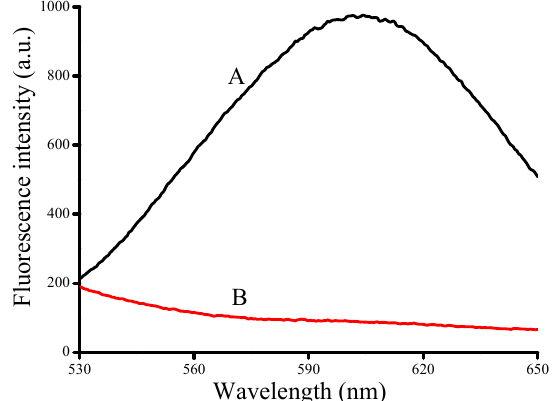
Figure 1. The feasibility of the proposed method. ( A ) Synthesis of CuNPs with 500 nM T40, 100 µM CuSO 4 and 1 mM Vc; ( B ) 500 nM T40, 100 µM CuSO 4 and 1 mM Vc were incubated for 10 min at room temperature after prep-incubation of the CuSO 4 with 5 µM HSA for 15 min at room temperature.